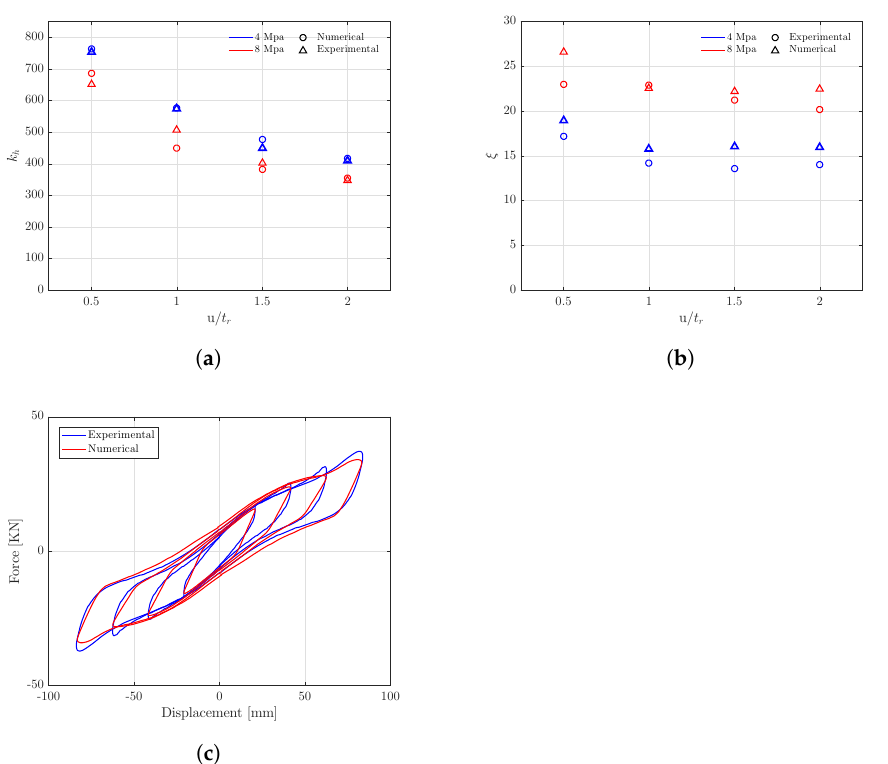
Figure 7. Comparison of predicted and experimental behaviors. ( a ) Experimental and predicted horizontal stiffness. ( b ) Experimental and predicted damping ratios. ( c ) Force-displacement curves under 4 MPa vertical